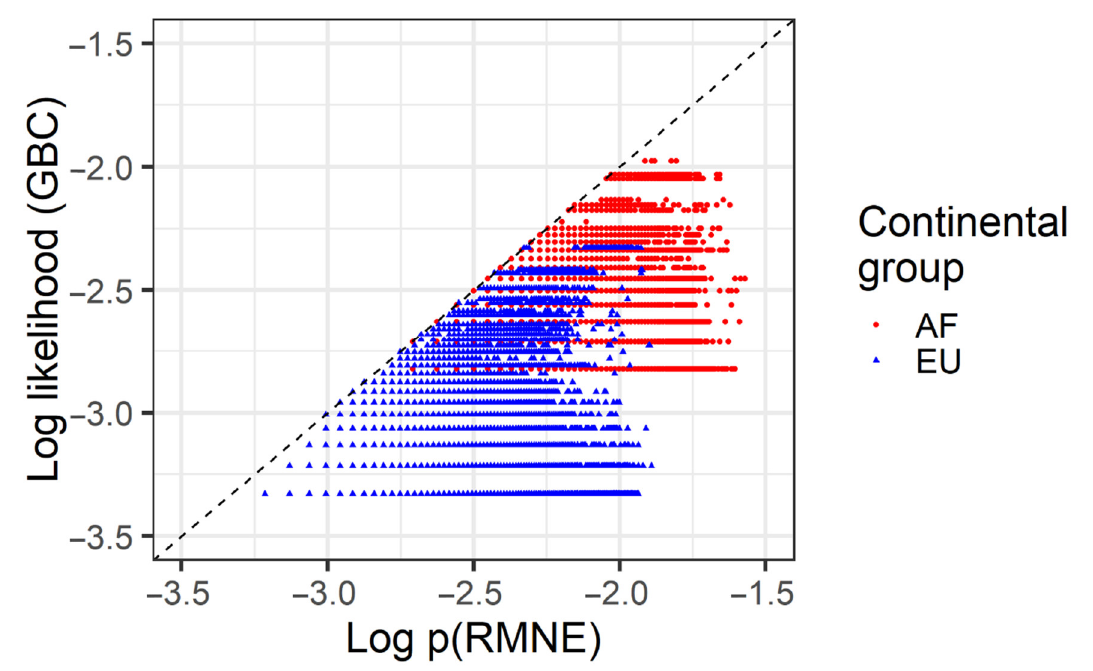
Figure 11. Match statistics of two-person mixtures. The two-person mixtures were created within each of two continental groups (colors, AF: African, EU: European) by sampling haploid sequences from a database. The likelihood of the pair (treating one individual as an unknown, log 10 transformed, y -axis) is contrasted against the probability of the random man not excluded (p(RMNE), log 10 transformed, x -axis).